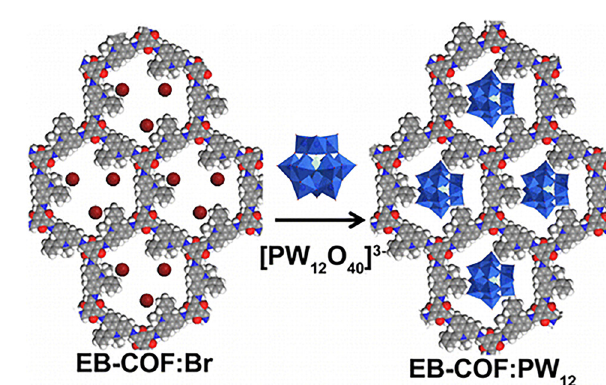
Figure 14: Electrostatic interaction of POM with CDs and their mechanistic illustration for photoinduced water oxidation. Adopted with permission from ref. [151].